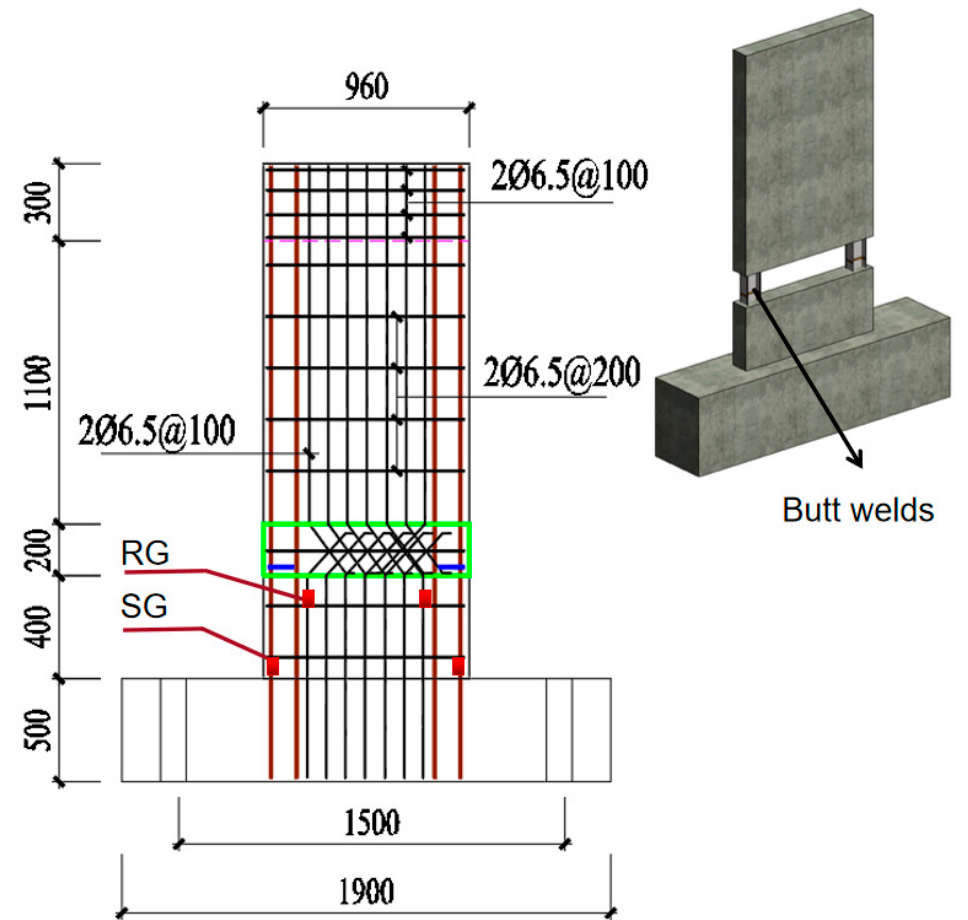
Figure 4. Layout of the wall specimen with the connection 400 mm above the footing (named XZW3 and 4). Unit: mm. RG represents “strain gauge attached on the reinforcing bar”, and SG “strain gauge attached on the I-steel section” ( Φ is the diameter of bars , @ is the center-to-center distance of bars.)